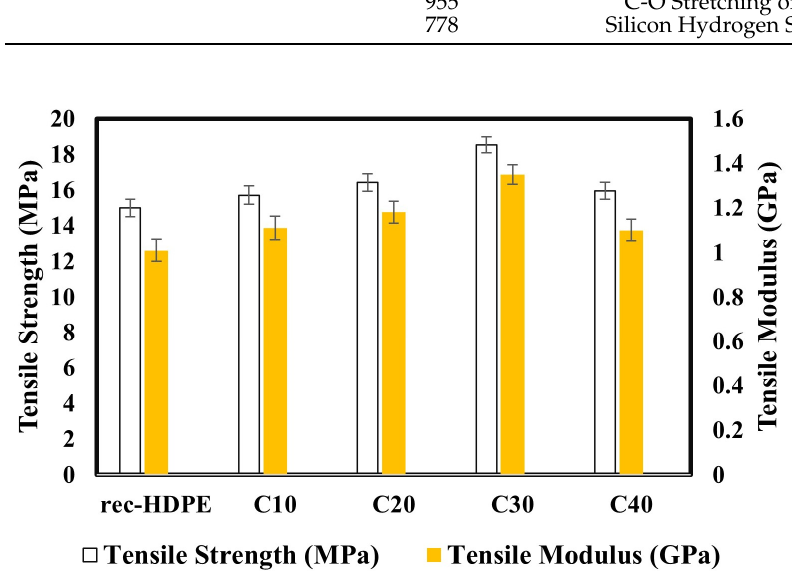
Figure 2. Tensile properties of the recycled HDPE and composites.